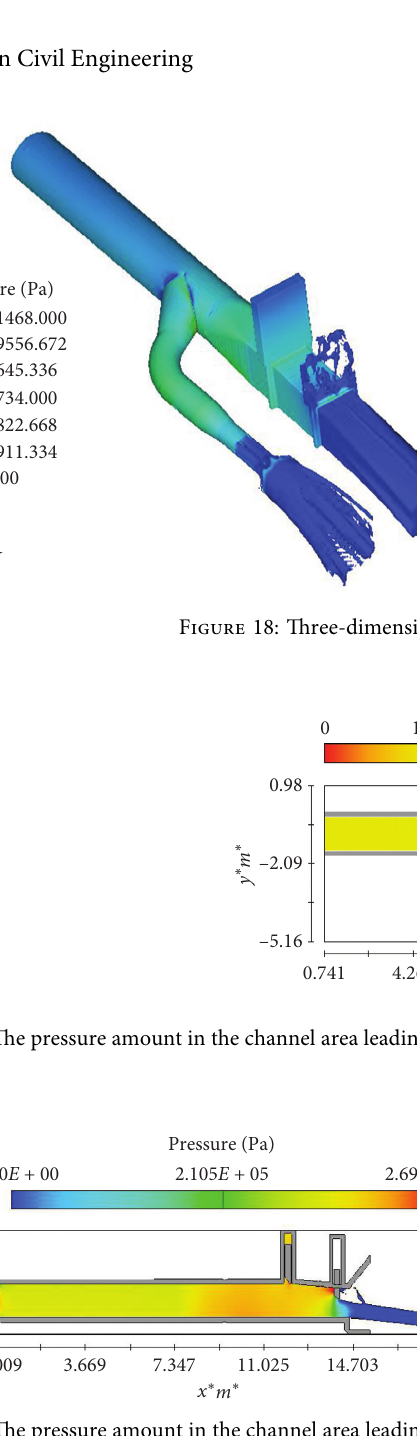
Figure 21: The pressure amount in the channel area leading to the gate and the branch in the state of 20% opening (100% valve